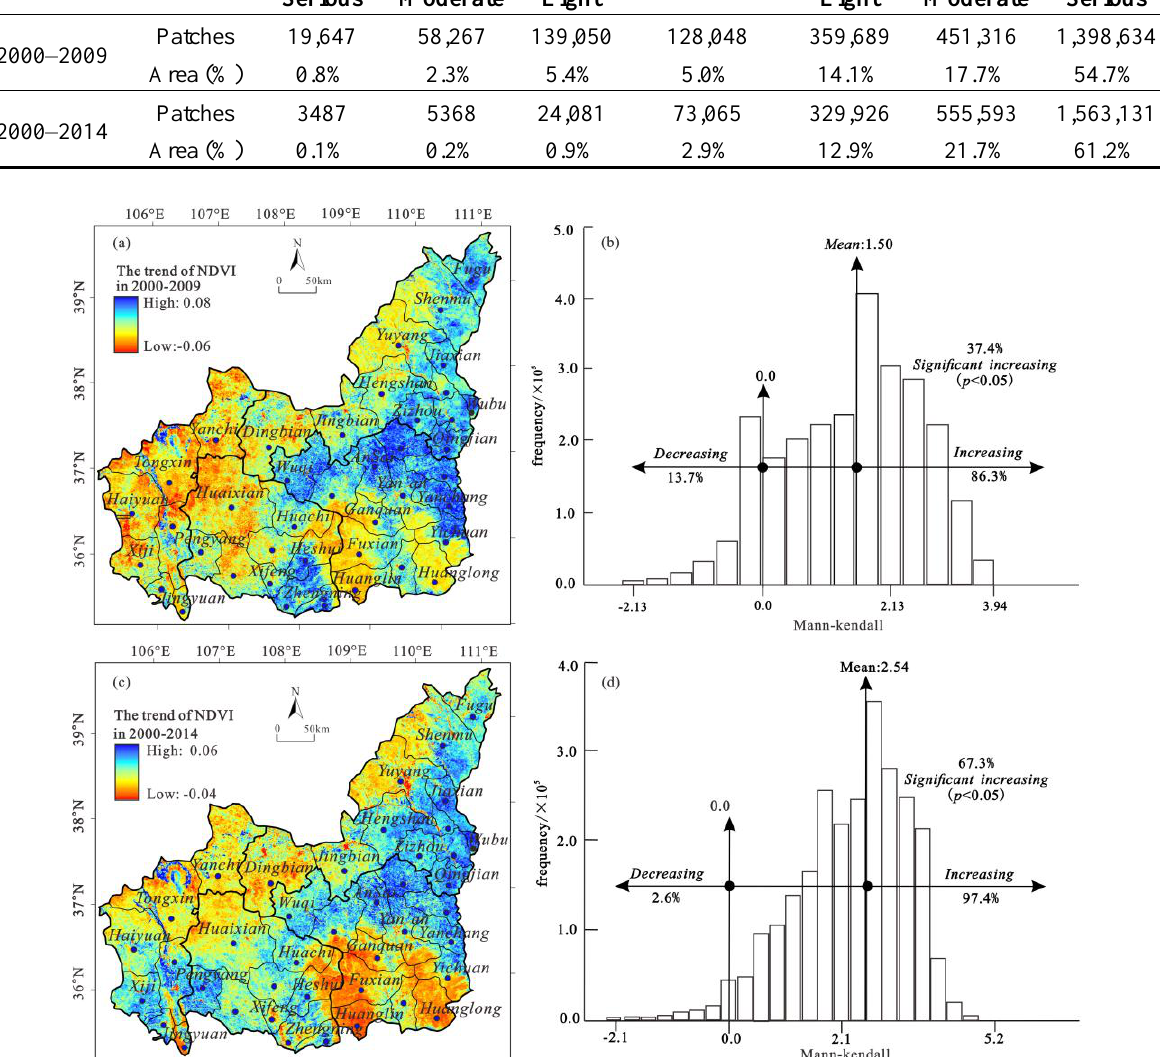
Figure 3. NDVI trends and their distribution in the Shaanxi-Gansu-Ningxia region. ( a ) The trend of NDVI changes from 2000 to 2009; ( b ) The distribution of NDVI trends from 2000 to 2009; ( c ) The trend of NDVI changes from 2000 to 2014; ( d ) The distribution of NDVI trends from 2000 to